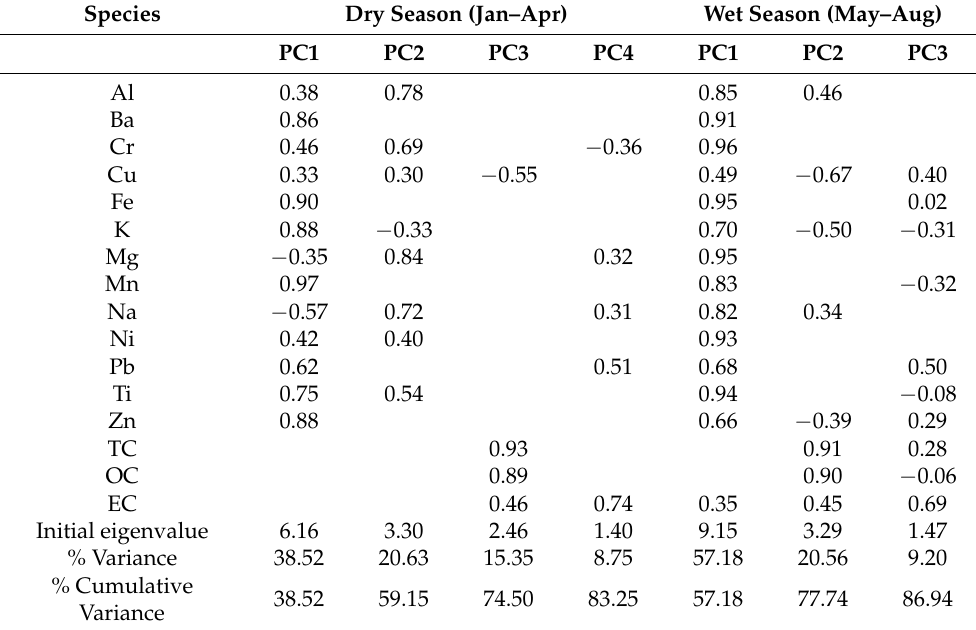
Table 6. Principal components in the TSP fraction by season.